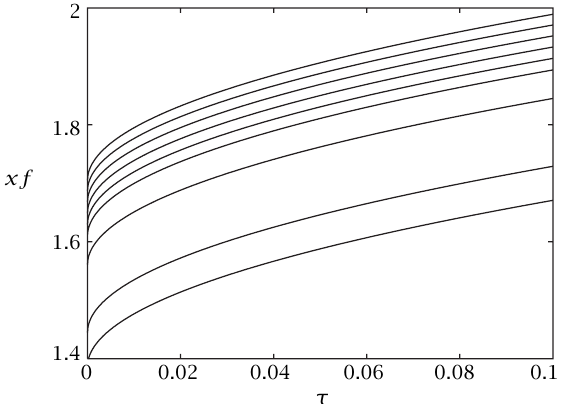
Figure 2.2 . Location of the free boundary for several values of r and D 0 .